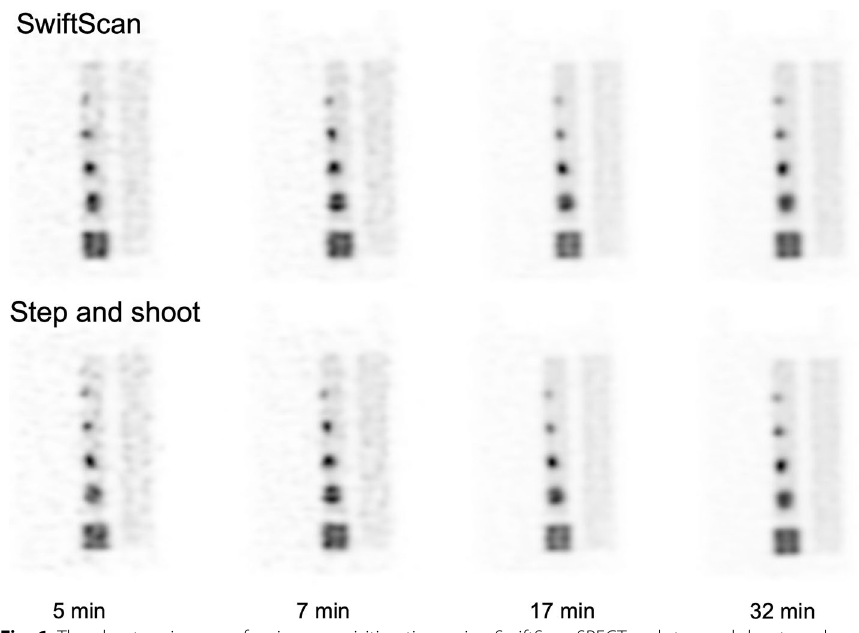
Fig. 6 The phantom images of various acquisition time using SwiftScan SPECT and step and shoot mode (SSM). The upper row shows SwiftScan SPECT and the lower row shows SSM